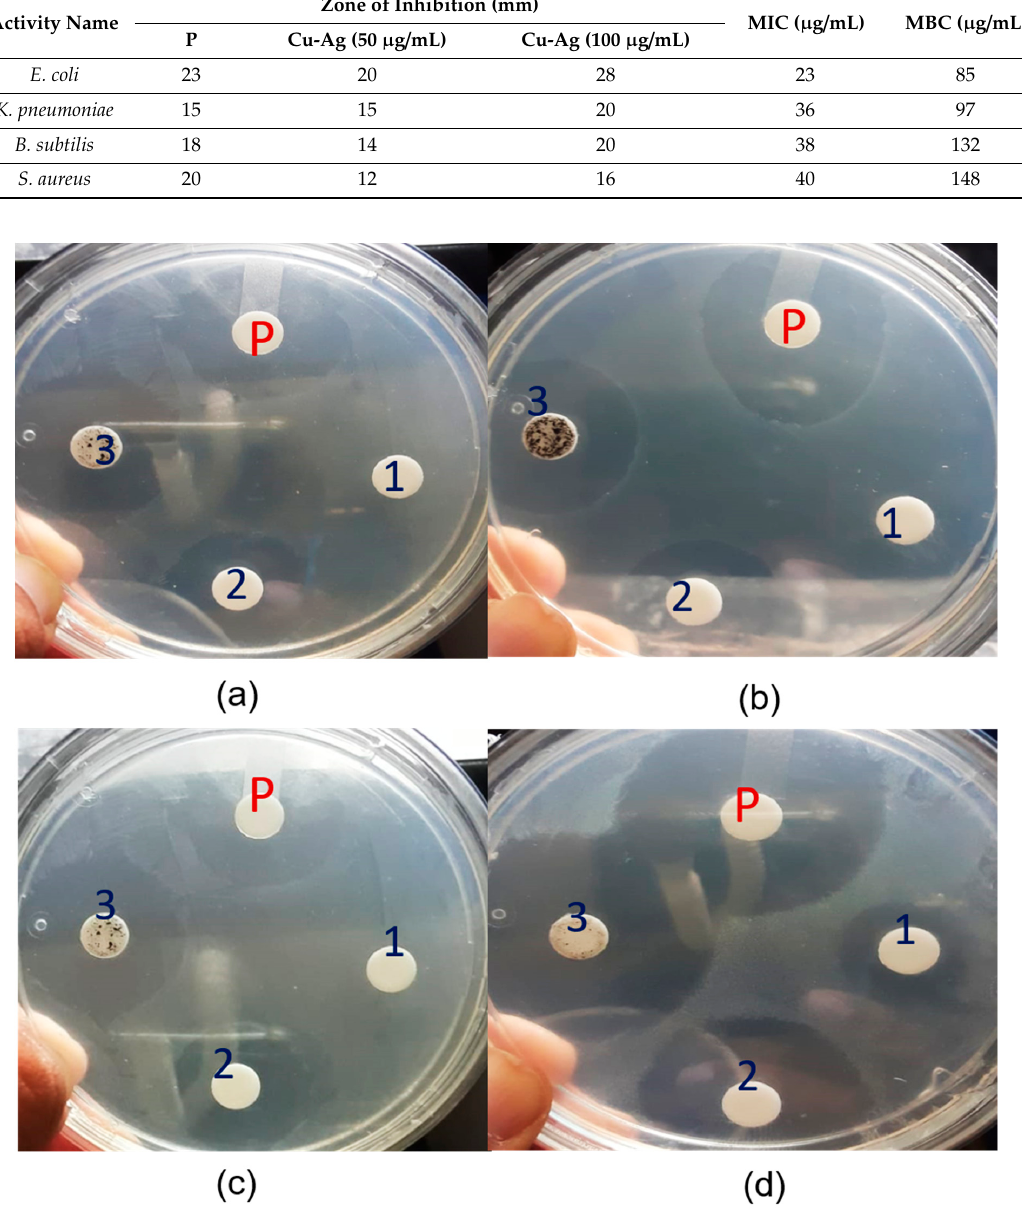
Figure 6. Photographs of Antimicrobial activity of Cu-Ag NPs against different bacteria: ( a ) Bacillus , ( b ) Staphylococcus , ( c ) Klebsiella , and ( d ) E. coli (P–Penicillin, 1-DMSO, 2- Cu (50 ug), 3- Cu-Ag (100 ug).